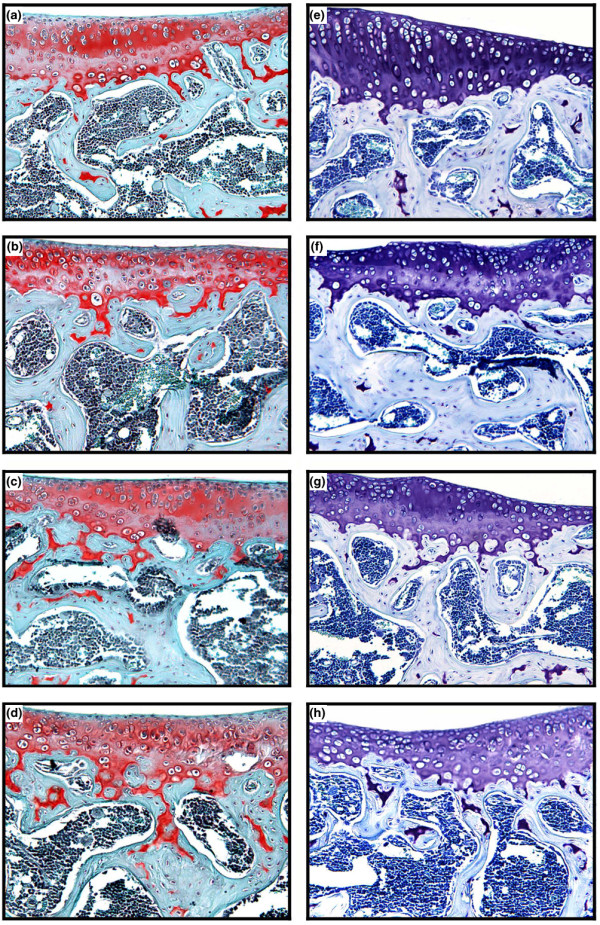
Representative histological sections of specimens from mice stained with (a-d) safranin O or (e-h) toluidine blue (magnification ×100). Control group (a,e). Mice were injected with 0.1 μg (b,f), 1 μg (c,g), or 10 μg (d,h) galectin-3.